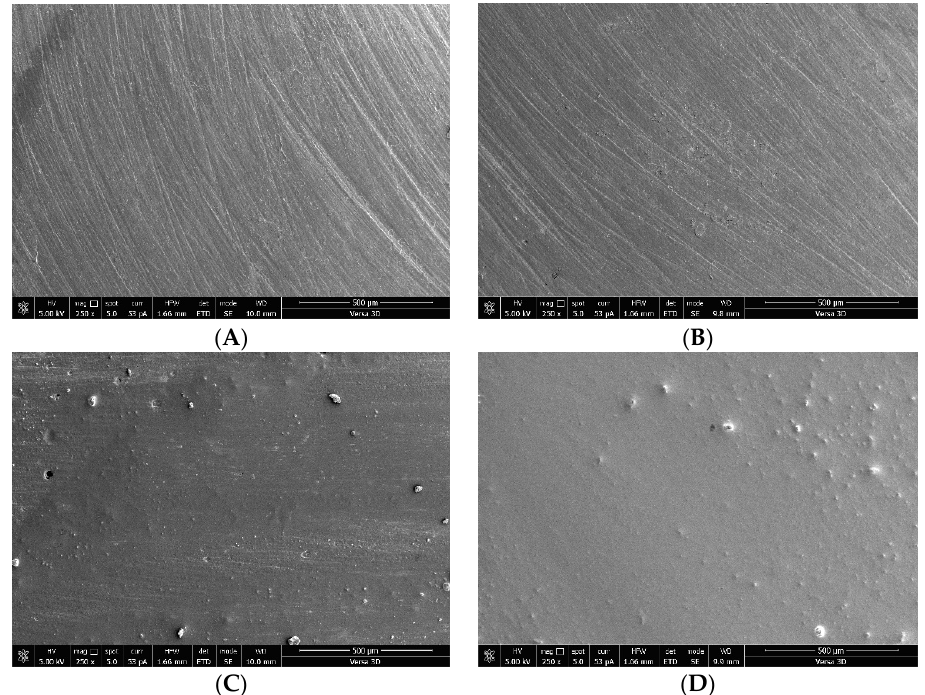
Figure 1. SEM pictures of adhesive failure pattern: ( A ) group 1; ( B ) group 2; ( C ) group 4; and ( D ) group 5.